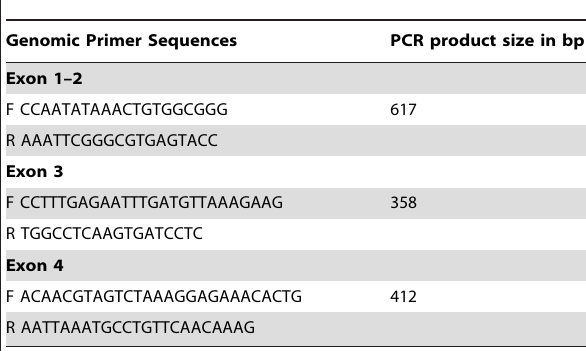
Table 1. Genomic PCR Primer sequences for KIAA0101